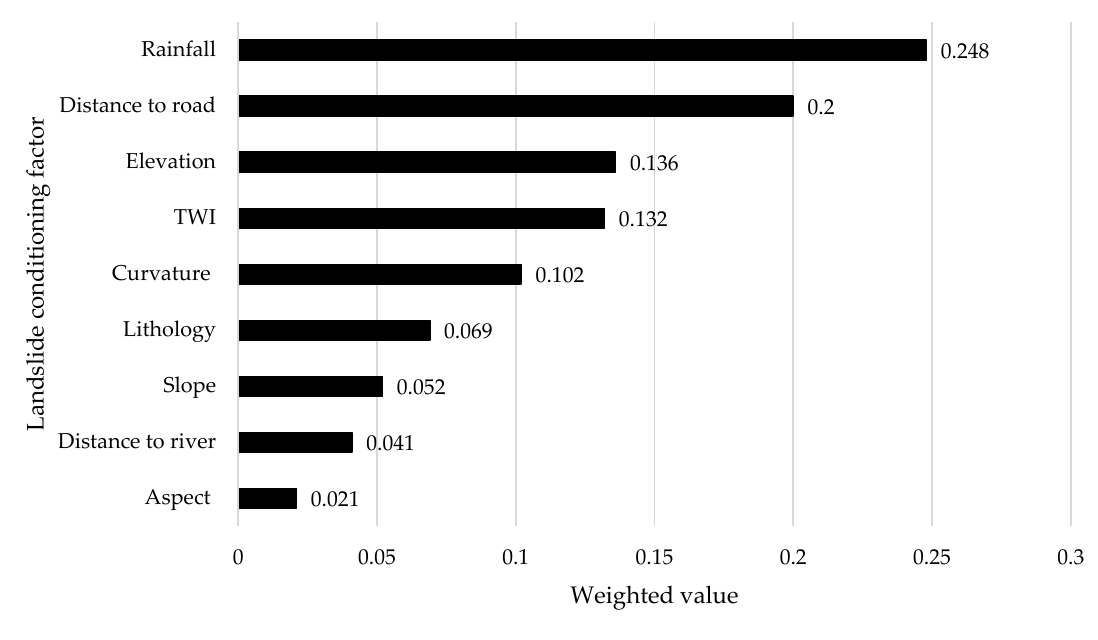
Figure 7. Importance of landslide conditioning factors.